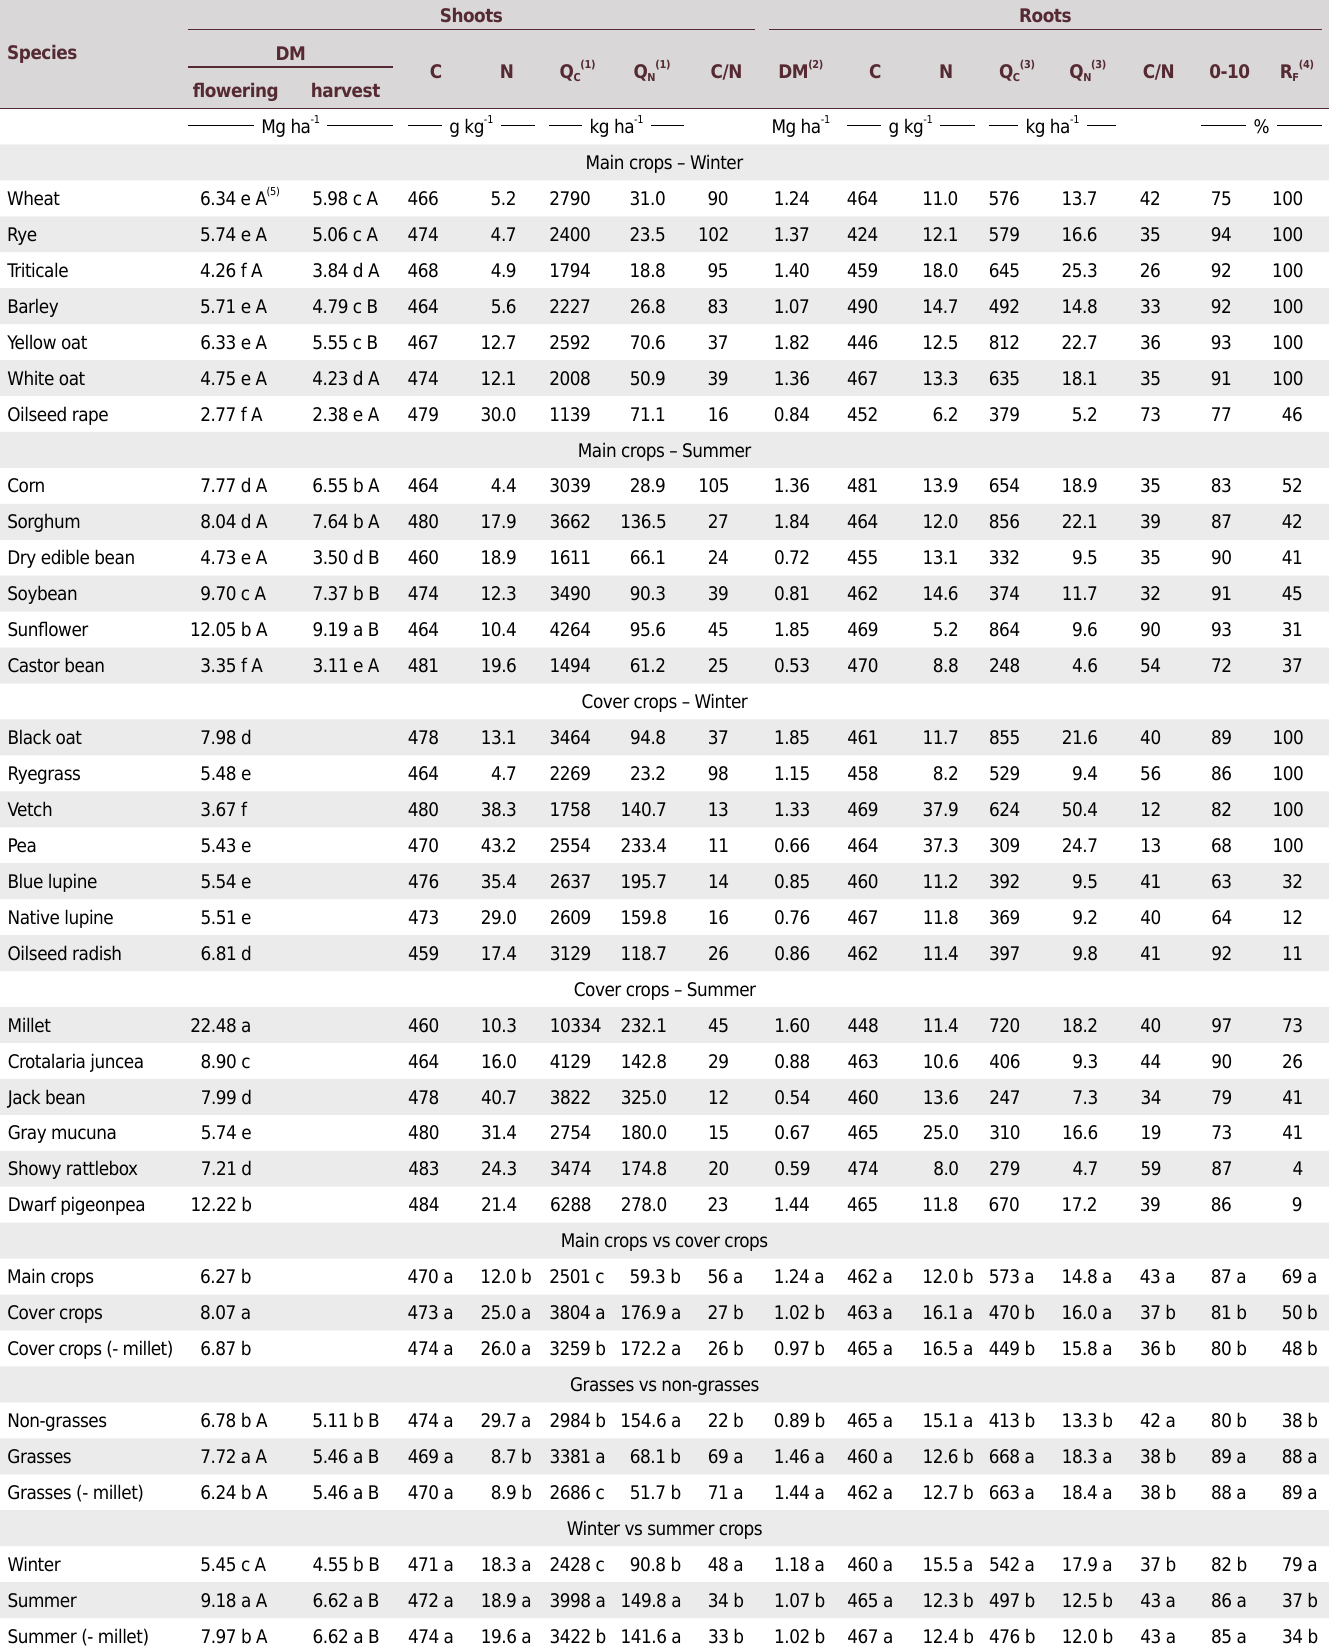
Table 3. Dry matter, accumulation of C and N in shoots and roots of main crops and cover crops Shoots Roots Species DM